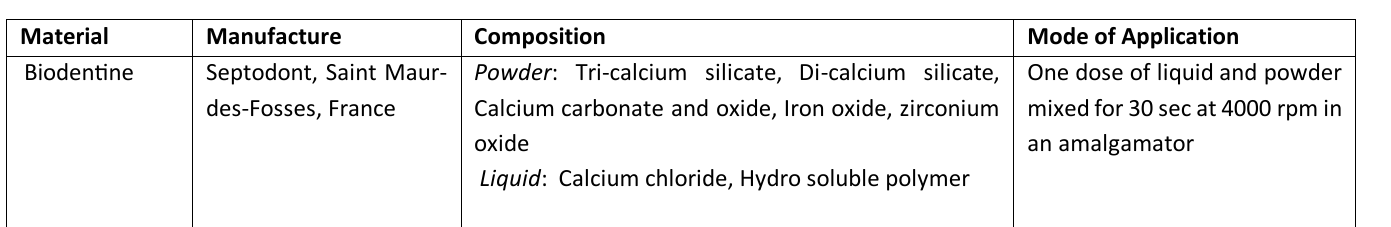
Table 1 – Materials composition and mode of application: Material Manufacture Composition Mode of Application